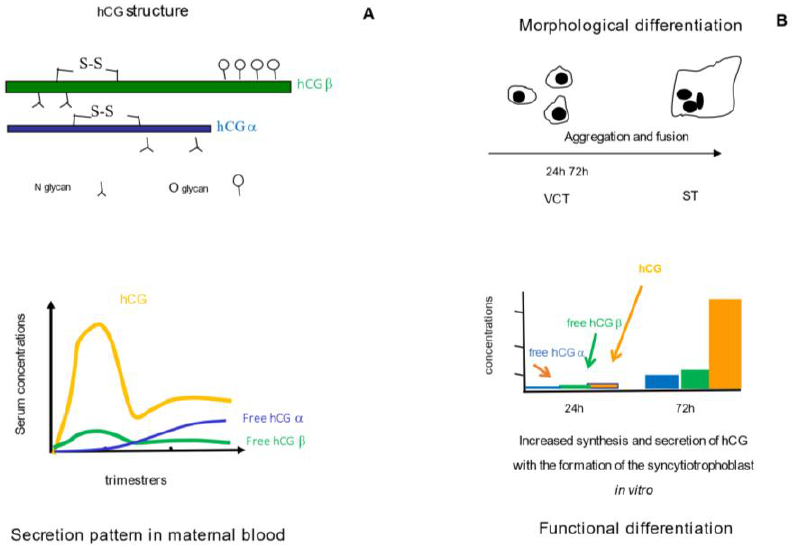
Figure 1. Structure and secretion of hCG in vivo ( A ) and in vitro ( B ). hCG is a dimeric glycoprotein composed of a common α subunit (hCG α ), and a specific ß subunit (hCG β ). The secretion of hCG and its free ß subunit in maternal blood increase during the first trimester of gestation, and decrease thereafter; the secretion of its free α subunit increases all through pregnancy in line with placental mass ( A ). In vitro and vivo, the morphological differentiation of the villous cytotrophoblasts (VCT) into a syncytiotrophoblast (ST) is mainly associated with functional differentiation, as assessed by the increasing production of hCG and its subunits ( B ).